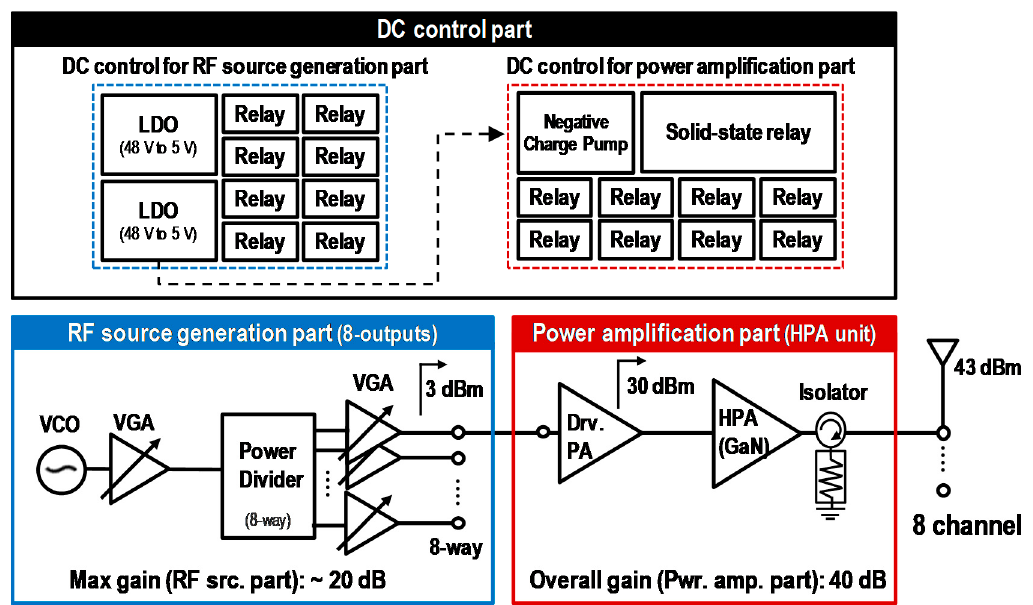
Figure 1. The block diagram of the proposed module .